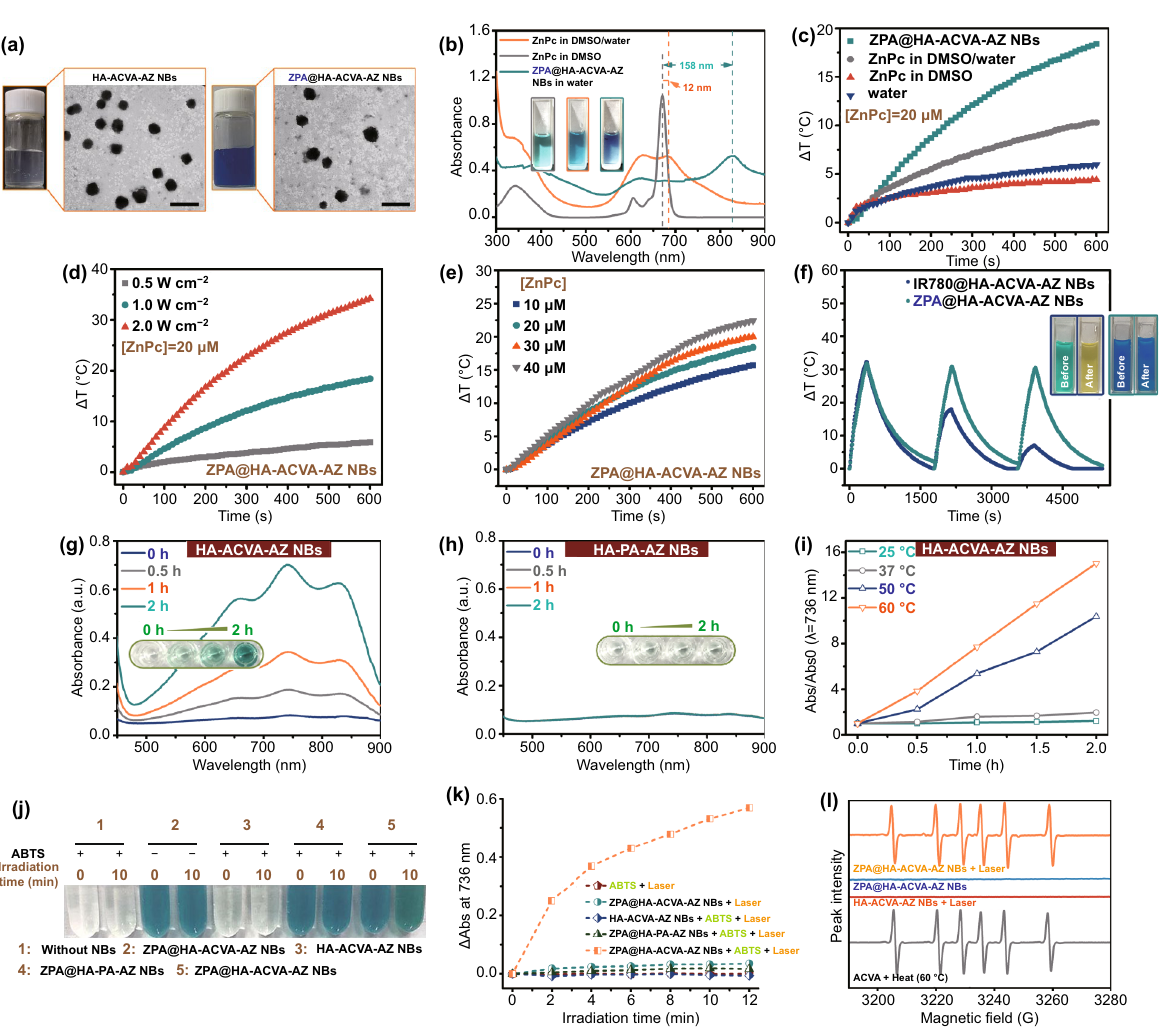
Fig. 2 Characterizations of ZPA@HA-ACVA-AZ NBs. a Digital images and TEM images of blank HA-ACVA-AZ NBs and ZPA@HA-ACVA- AZ NBs (scale bars: 500 nm). b Electronic absorption spectra of ZPA@HA-ACVA-AZ NBs in deionized water, ZnPc in DMSO/water (5/95, v/v) and ZnPc in DMSO and digital images of corresponding solution (insets). c Temperature variation of various samples as a func- tion of the irradiation time at a power density of 1 W cm −2 ([ZnPc] = 20 μM for ZPA@HA-ACVA-AZ NBs, ZnPc in DMSO/water and ZnPc in DMSO). d Plots of the temperature variation of ZPA@HA-ACVA-AZ NBs over 10 min upon irradiation at different laser power densities ([ZnPc] = 20 μM). e Plots of the temperature increase of ZPA@HA-ACVA-AZ NBs over 10 min upon irradiation at different concentrations of ZPA@HA-ACVA-AZ NBs at a power density of 1 W cm −2 . f Temperature curves for ZPA@HA-ACVA-AZ NBs ([ZnPc] = 20 μM) and IR780@ HA-ACVA-AZ NBs ([IR780] = 20 μM) upon 808-nm laser irradiation (3 W cm −2 ) repeatedly (insets: digital images of NB solution before or after laser irradiation). g Generation of ABTS +• as induced by the free radicals released from blank HA-ACVA-AZ NBs at 50 ℃ with different incubation times. h Generation of ABTS +• as induced by the free radicals released from blank HA-PA-AZ NBs at 50 ℃ with different incubation times. i Absorbance of ABTS +• at 736 nm generated from the reaction of ABTS and blank HA-ACVA-AZ NBs under 0–2-h incubation at vari- ous temperatures. j Images of various samples with or without laser irradiation (1 W/cm 2 , 10 min) in the presence of ABTS. k Absorbance of ABTS +• at 736 nm generated from the reaction of ABTS and ZPA@HA-ACVA-AZ NBs under 0–12 min laser irradiation. l Electron spin